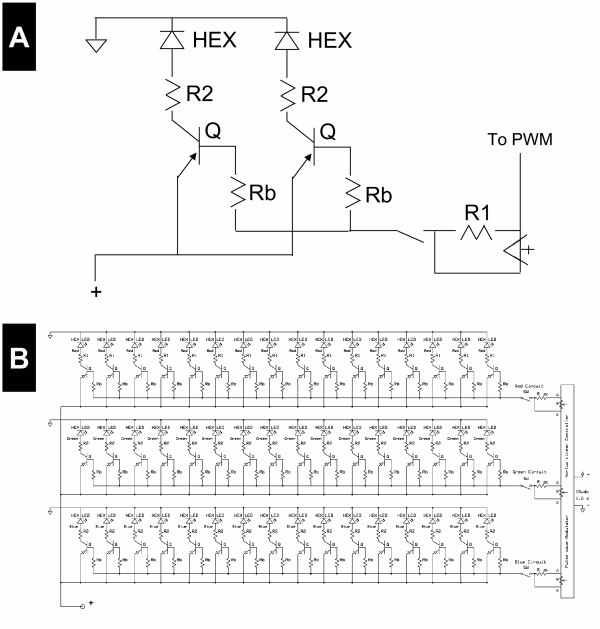
The circuitry powering the large LED banks. A) Two repeat units, driving two independent sets of 30 dies in Norlux HEX arrays. Q = TIP 170 PnP transistor; R1 = 22 ohm, 1 watt, metal film resistor (+/- 5%); R2 = 20 ohm, 1 watt, metal film resistor (+/- 5%); Rb = 4.7 k ohm, ½ watt, metal film resistor (+/- 5%). B) The assembly of the individual units into a controller for red, blue and green circuits in a 16 HEX array.